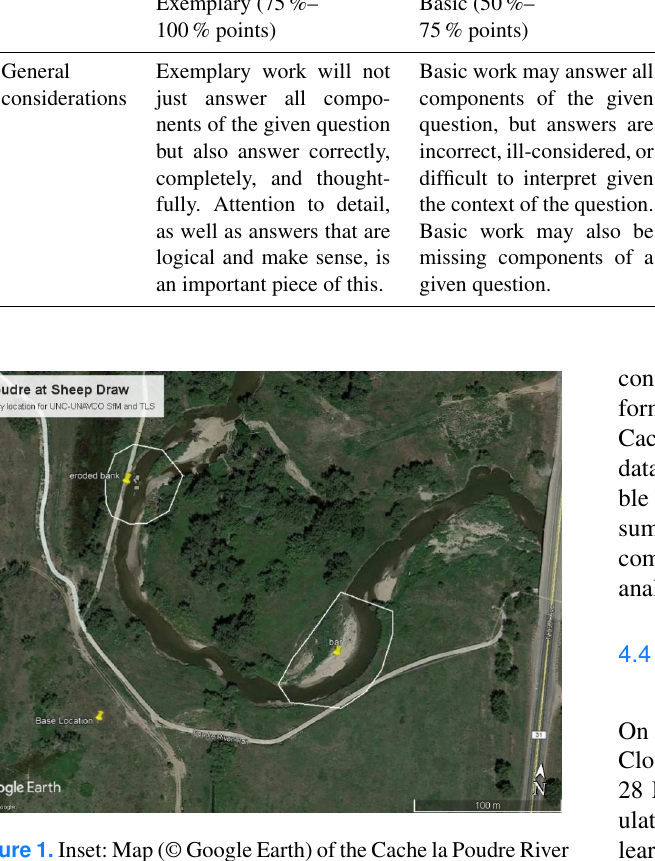
Figure 1. Inset: Map (© Google Earth) of the Cache la Poudre River Watershed, located in northern Colorado, United States. The study site at Sheep Draw has two areas of interest, Area of Interest 1 on an eroded bank and Area of Interest 2, a cutbank and point